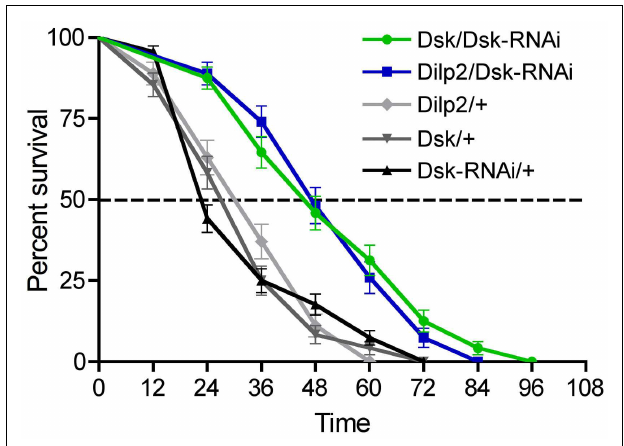
FIGURE 8 | Drosulfakinin and Drosophila insulin-like peptide deficient flies are more resistant to starvation. We tested the effect of Dsk -knockdown in the IPCs ( Dilp2 -Gal4/ Dsk -RNAi) and DPCs Dsk/Dsk -RNAi on survival at starvation. Using both Gal4 lines we obtained an extension of life span of the starved flies ( p < 0.01 and p < 0.001, n = 70–95 for each genotype, run in triplicate, Log-rank test), compared to the controls Dilp2/ + , Dsk/ + , and Dsk-RNAi/ + .The extension of lifespan seen here could be caused by the DSK and DILP deficient flies feeding more prior to the starvation experiment and thus having larger energy